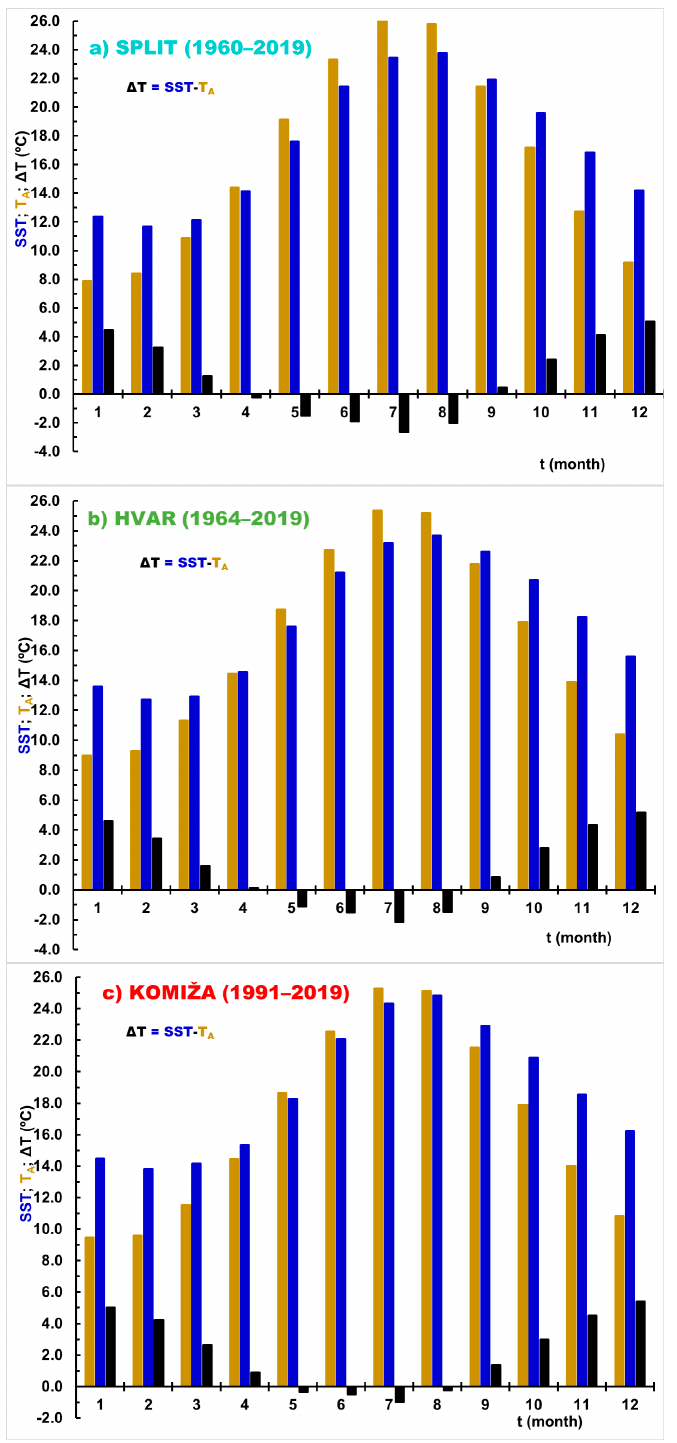
Figure 7. The average values of the monthly mean SST (blue), air temperature (brown), as well as their difference Δ T = SST-T A (black) from the time series measured at Split ( a ), Hvar ( b ), and Komiža ( c ) stations.